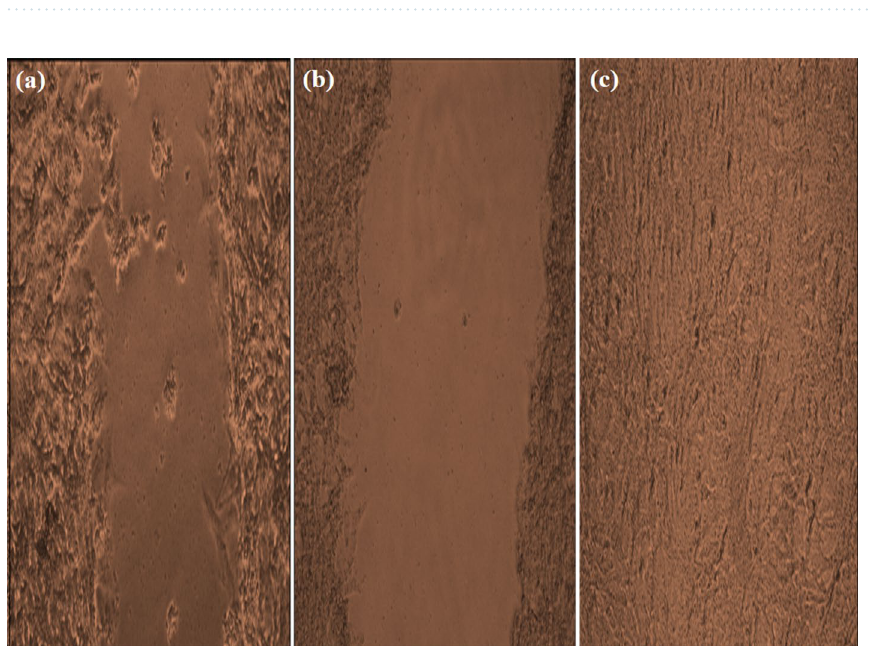
Figure 3. Photoimages for wound healing activities of ( a ) MNS against ( b ) the scratched Wi-38 cells in control with ( c ) unscratched Wi-38 cells (magnification ×